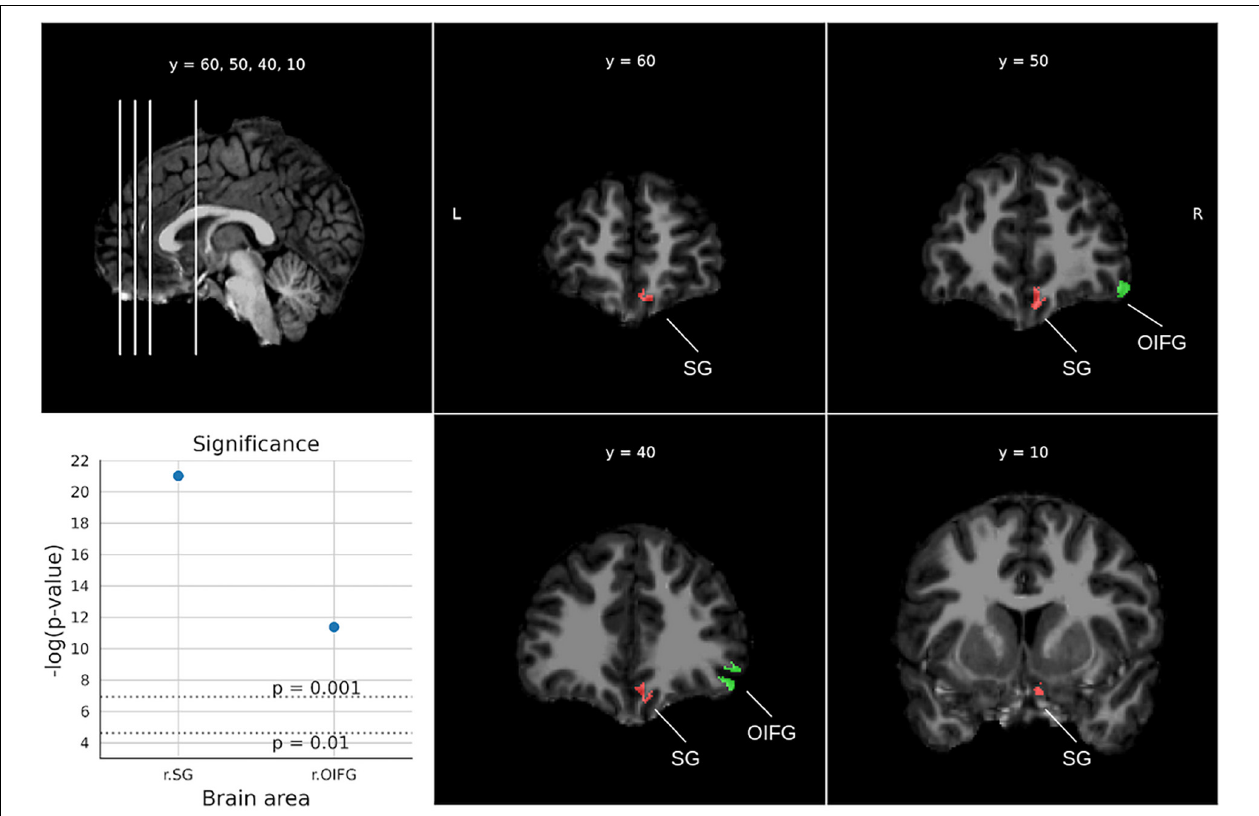
FIGURE 6 | Significant areas for the applied problems test with corresponding plots of the logarithmic p -values for each area. Coordinates are in MNI space. Brain areas: SG (Straight gyrus, Gyrus rectus), OIFG (Orbital part of the inferior frontal